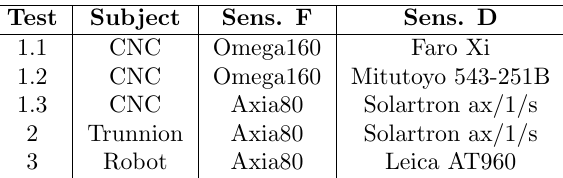
Table 2: Test numbering for different combinations of measurement devices and test subjects.